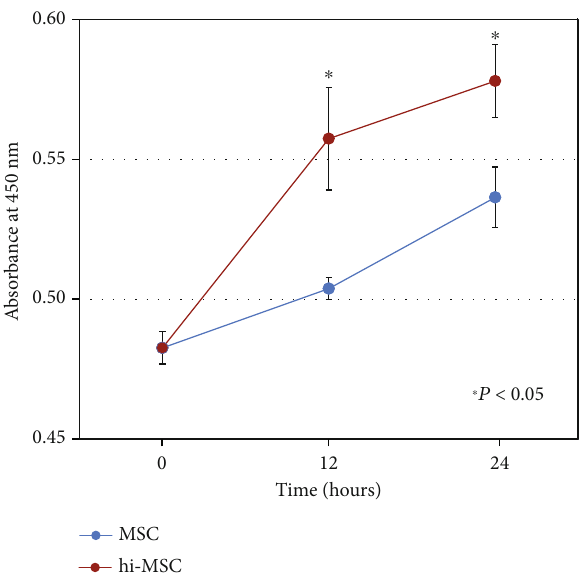
Figure 3: Cell viability and proliferation assays. The absorbance value of hypoxia-induced MSCs (hi-MSCs) was more signi fi cantly increased than that of mesenchymal stem cells (MSCs) in a time- dependent manner. The absorbance value of MSCs ( n = 5 ) and hi-MSCs ( n = 5 ) was assessed at each time point (0, 12, and 24